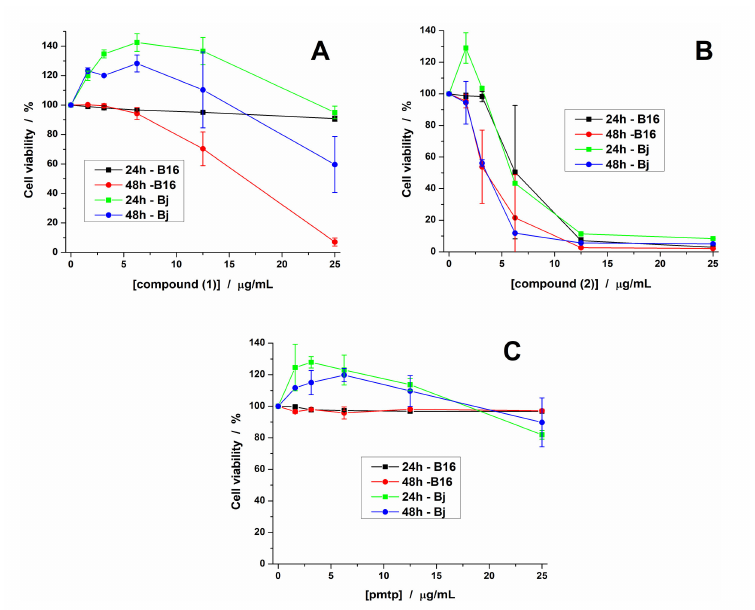
Figure 7. The cytotoxic e ff ect of compounds ( 1 ) ( A ), ( 2 ) ( B ) and pmtp ( C ) on BJ and B16 cells evaluated at 24 and 48 h (each value represents the mean ±